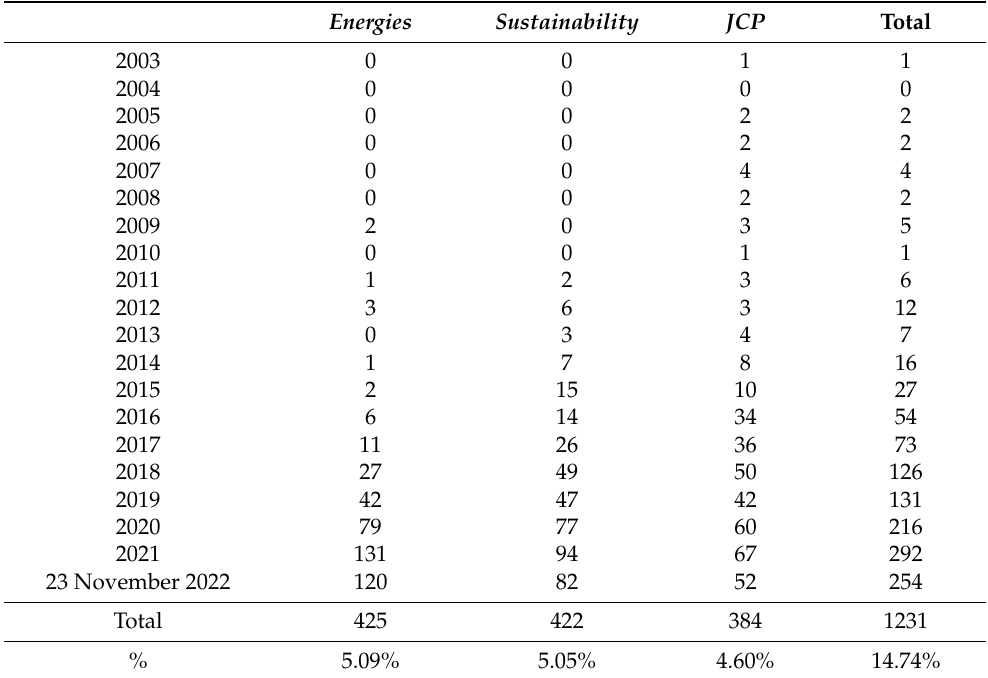
Table 2. Number of articles published by the top 3 journals in sustainable development and renew- able energy.